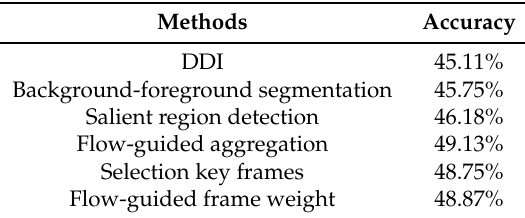
Table 3. Evaluation of different spatial/temporal weights estimation methods on the validation set of ChaLearn LAP IsoGD Dataset (only depth